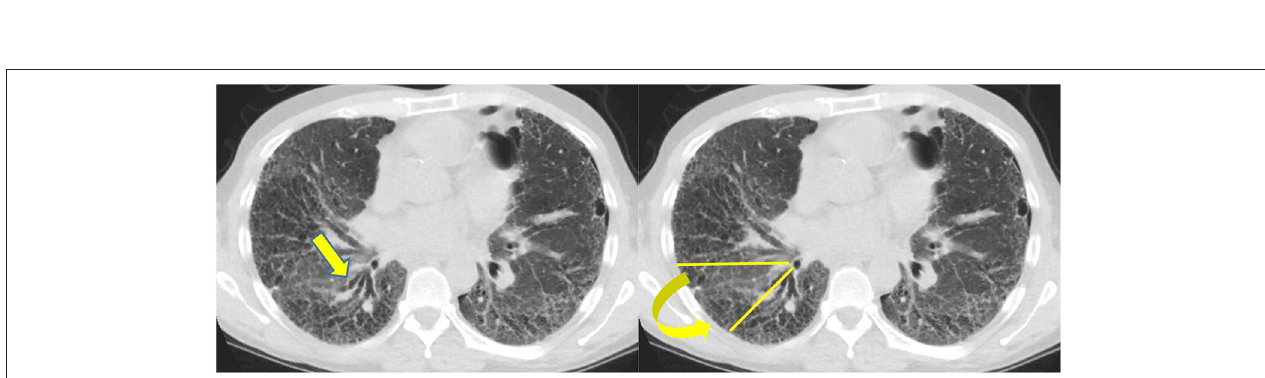
FIGURE 3 | Evolution of scleroderma from a cellular NSIP pattern to a mixed cellular and fibrotic pattern with bronchiectasis over the course of 10 months consistent with progressive disease.